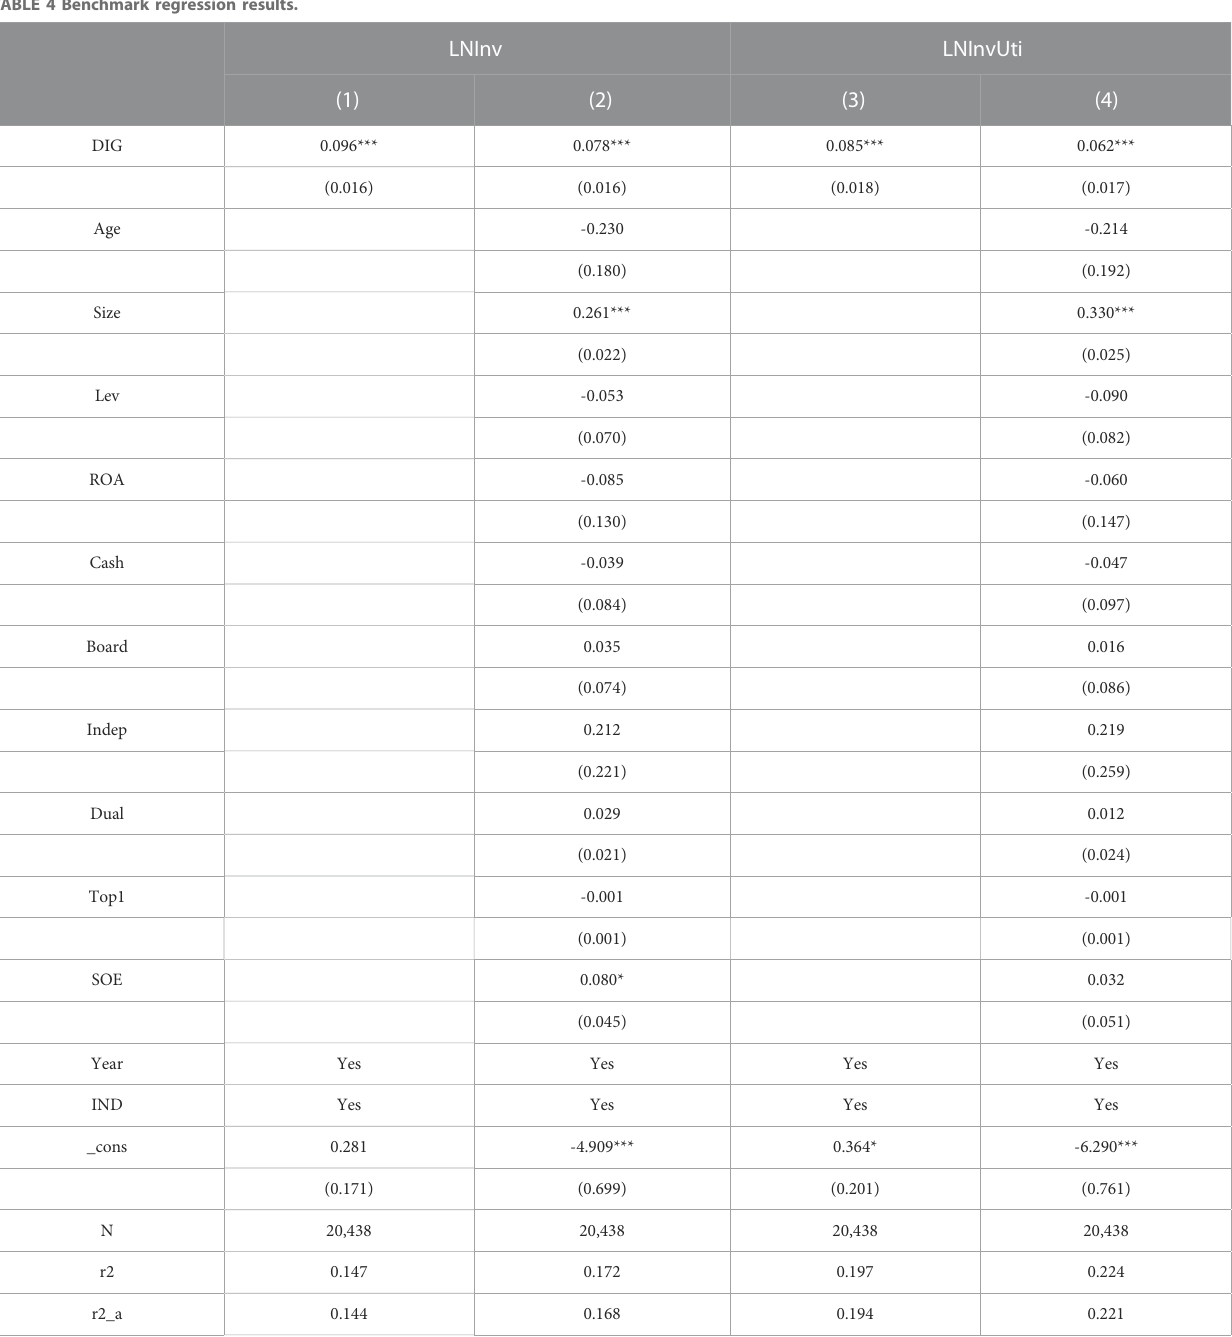
TABLE 4 Benchmark regression